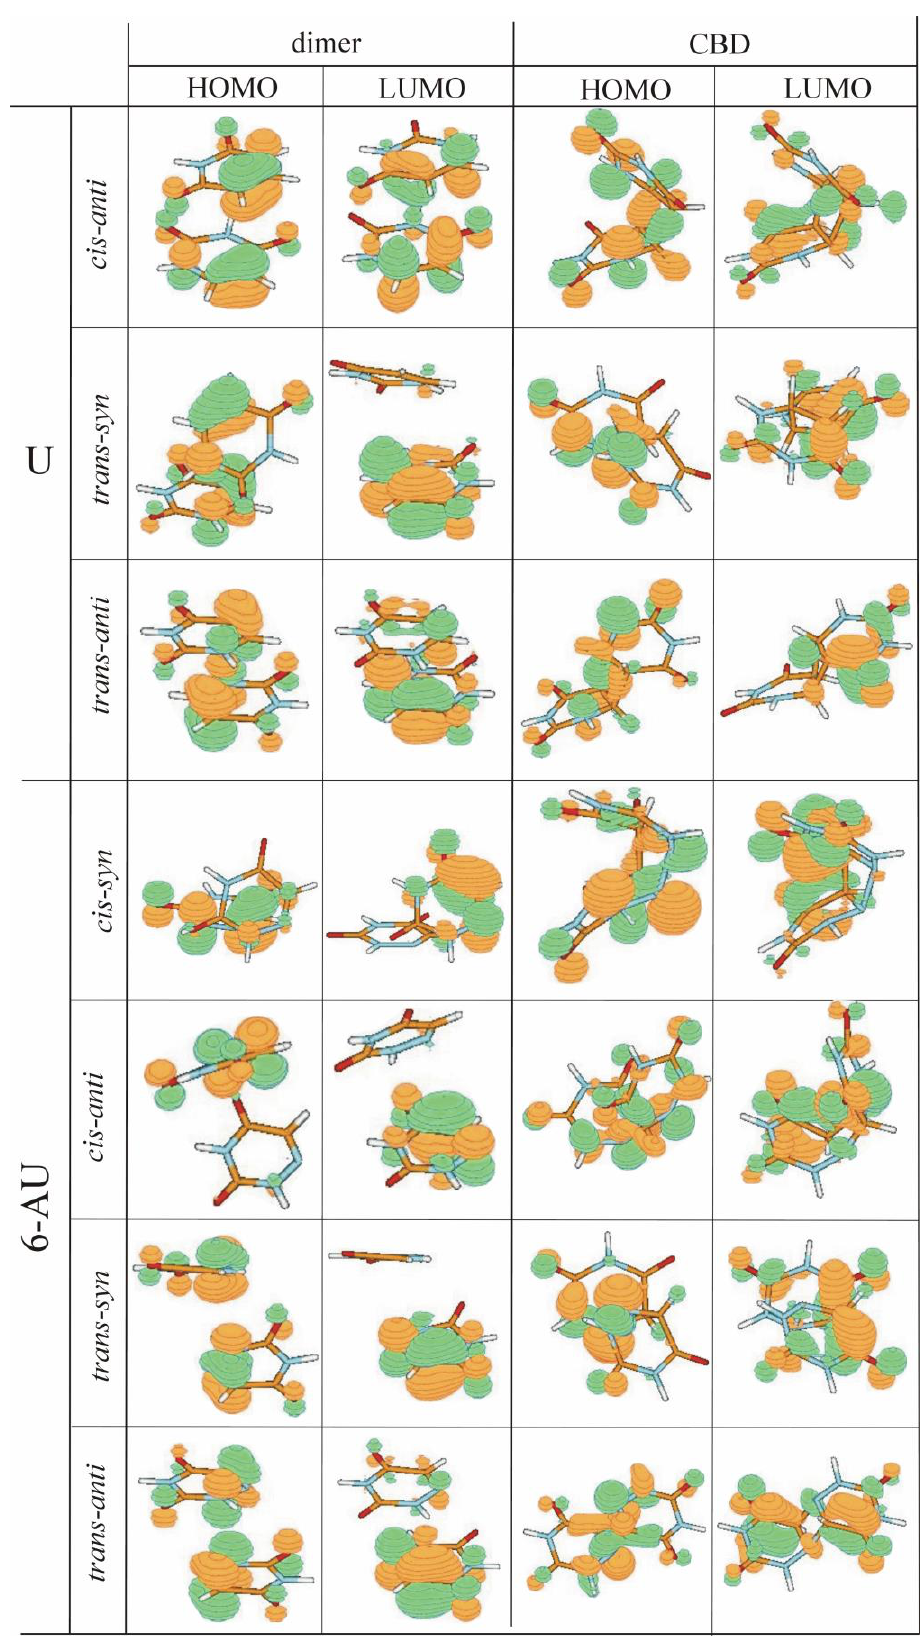
Fig. S1. HOMO and LUMO molecular orbitals of the CBDs and the SDs included in the active space